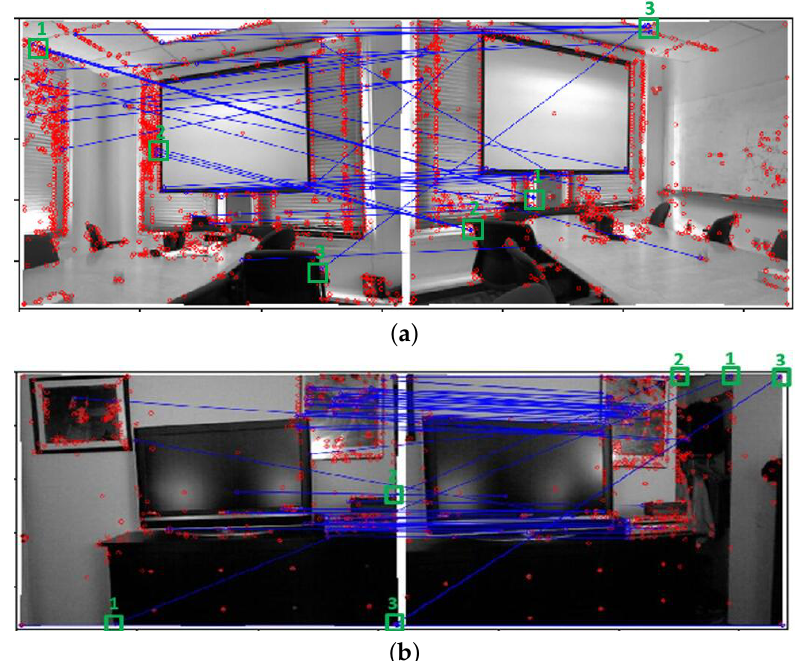
Figure 12. SIFT algorithm matching results: ( a ) Figure 9a,b matching result of SIFT algorithm; ( b ) Figure 10a,b matching result of SIFT